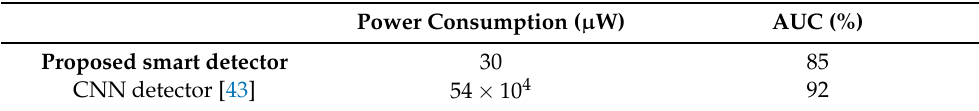
Table 3. Area Under the Curve (AUC) and power consumption comparison with the state-of-the-art detectors using the labeled database composed of samples from the BOMBYX project sonobuoy [33]. Power Consumption ( µ W) AUC (%) Proposed smart detector 30 85 CNN detector [43] 54 × 10 4